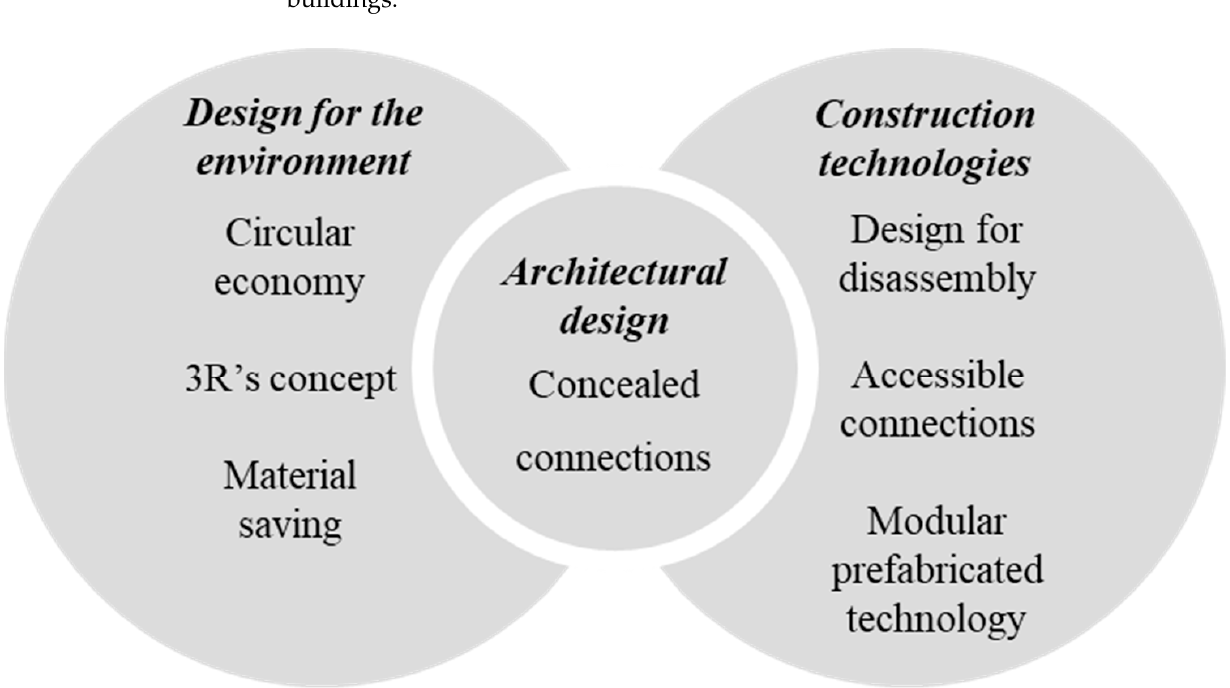
Figure 1. The theoretical framework of this study.